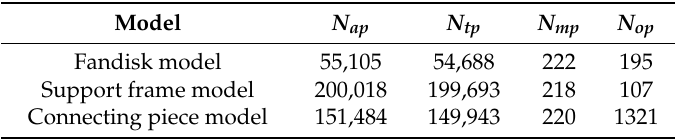
Table 4. Defining assessment quantities.